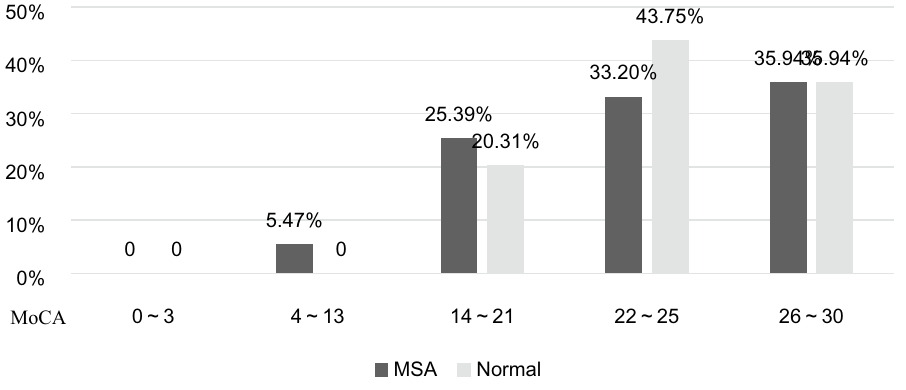
Figure 1. Total MoCA score distribution for MSA patients. Note: (MSA, n = 256) and controls (normal, n = 64).